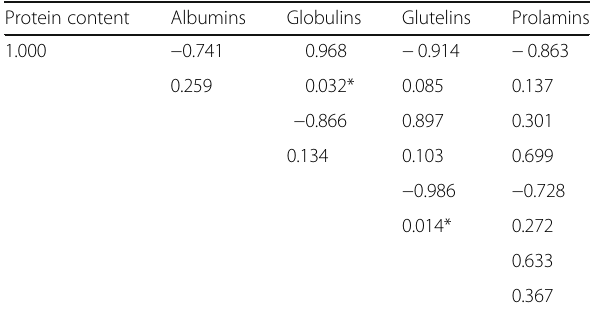
Table 9 Bivariate correlation between protein content and four protein fractions in the cotton lines of G.